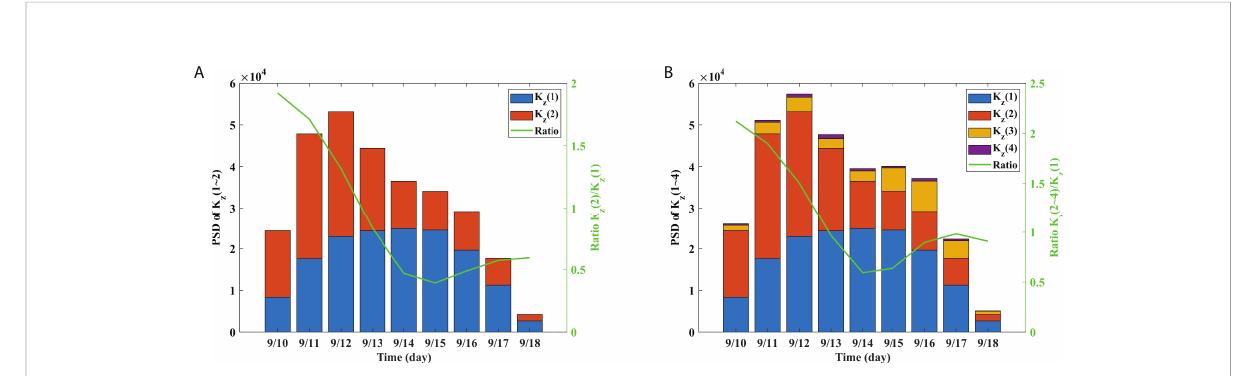
FIGURE 8 The 24-h averaged PSDs of vertical DIT wavenumbers are shown. (A) PSDs of the lowest two vertical wavenumbers are plotted over the virtual mooring duration, along with the ratio (right y -axis). (B) PSDs of the lowest four vertical wavenumbers are plotted, along with the